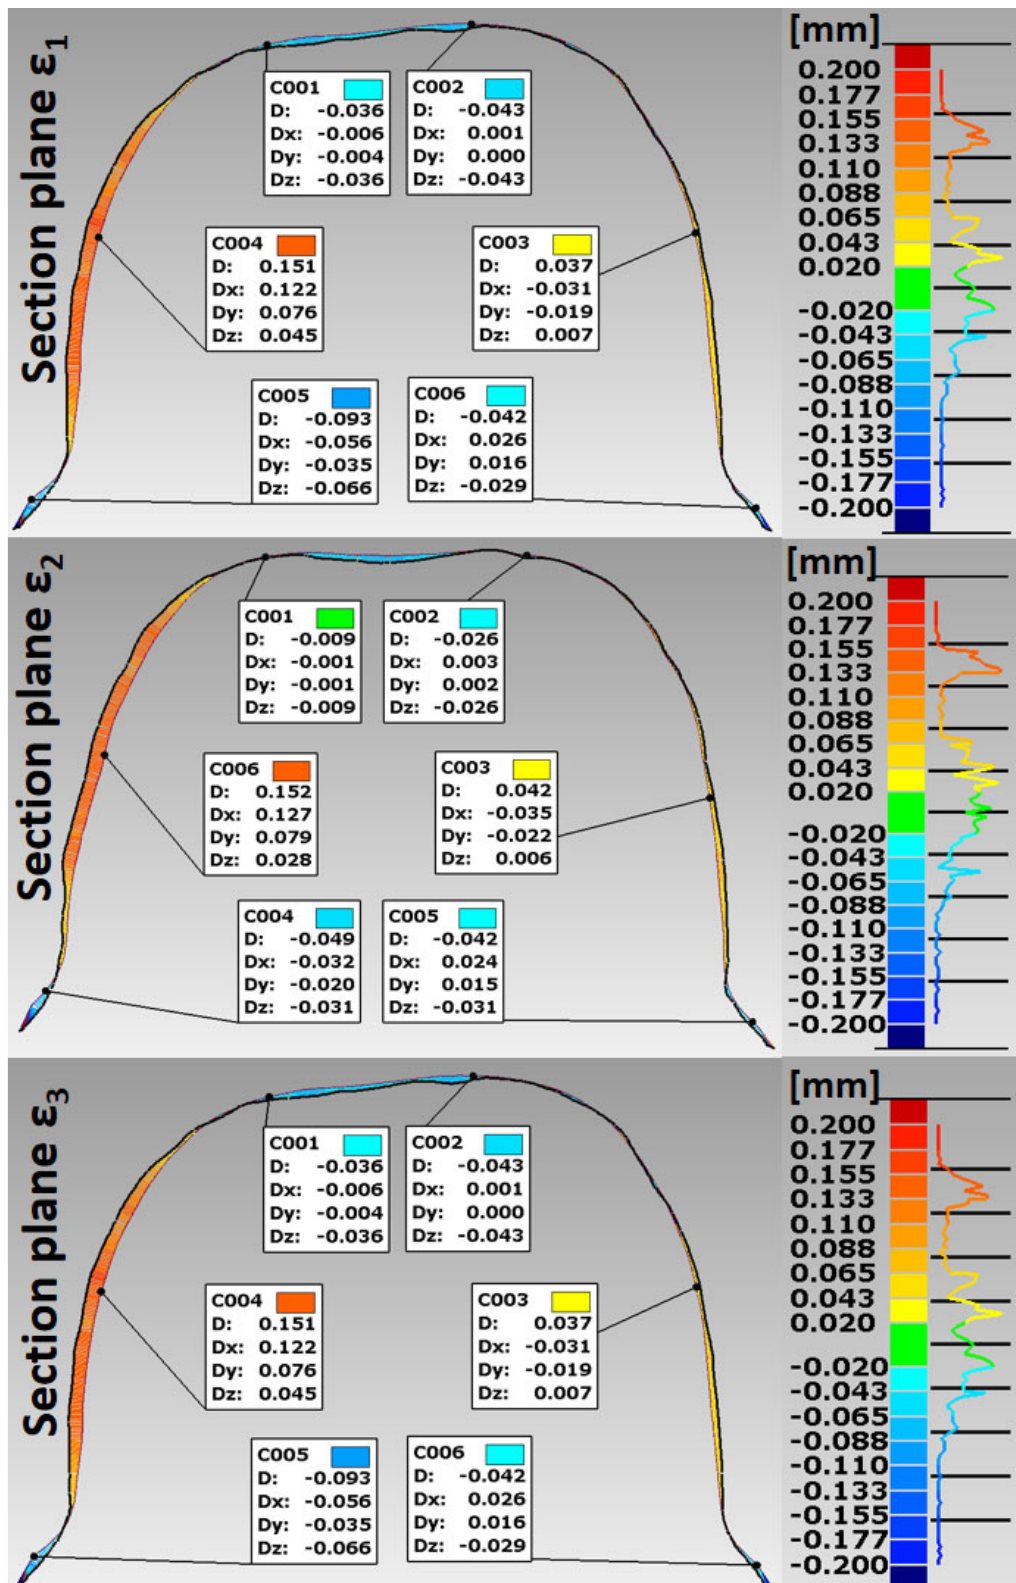
Figure 14. Distribution of deviations in the marginal and internal fit of a crown made of Ti6Al4V alloy in SLM for molar tooth 36.